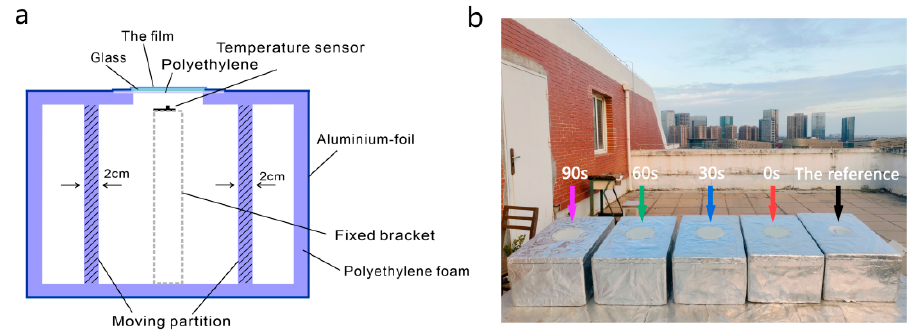
Figure 2. Schematic diagram of the test setup for passive radiative-cooling: ( a ) arrangement inside the passive radiation-cooling test chamber to minimize conduction and convection heat transfer; and ( b ) fi eld experimental setup on the test roof in Quanzhou, China.